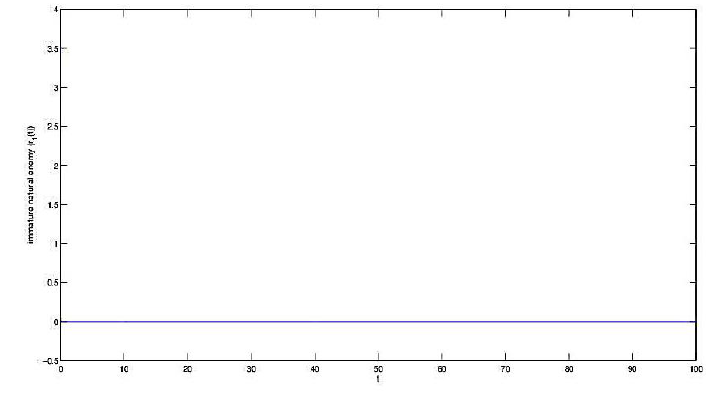
Figure 11. Immature natural enemy (𝑟